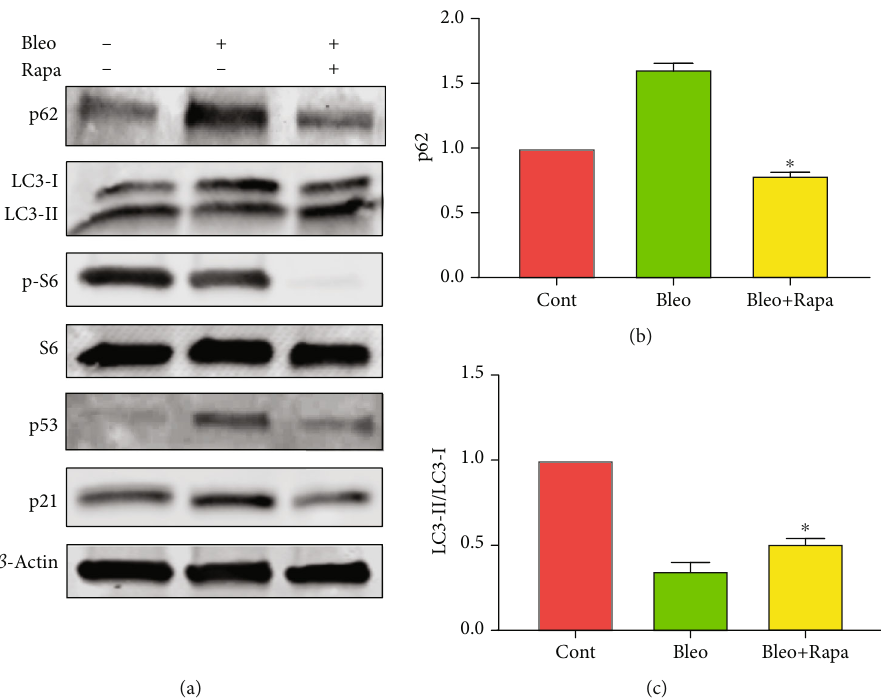
Figure 3: Rapamycin decreases PTSC senescence by upregulating autophagy. (a) Western blot analysis of p62, LC3-II/LC3-I, p-S6, S6, p53, and p21 shows that bleomycin induces LC3I, p62, p53, and p21; however, they are reduced by rapamycin. (b) Relative density of p62 bands. p62, whose level is inversely correlated with autophagy activity, is higher with bleomycin treatment, but rapamycin decreases the p62 expression. (c) LC3 II/LC3 I ratio, an indicator of autophagy activity, is signi fi cantly decreased in the bleomycin treated PTSCs, but increased after rapamycin treatment. Each data point represents at least three independent experiments. ∗ p < 0 : 05 , compared to the bleomycin treatment group. Cont: control; Bleo: bleomycin; Rapa: